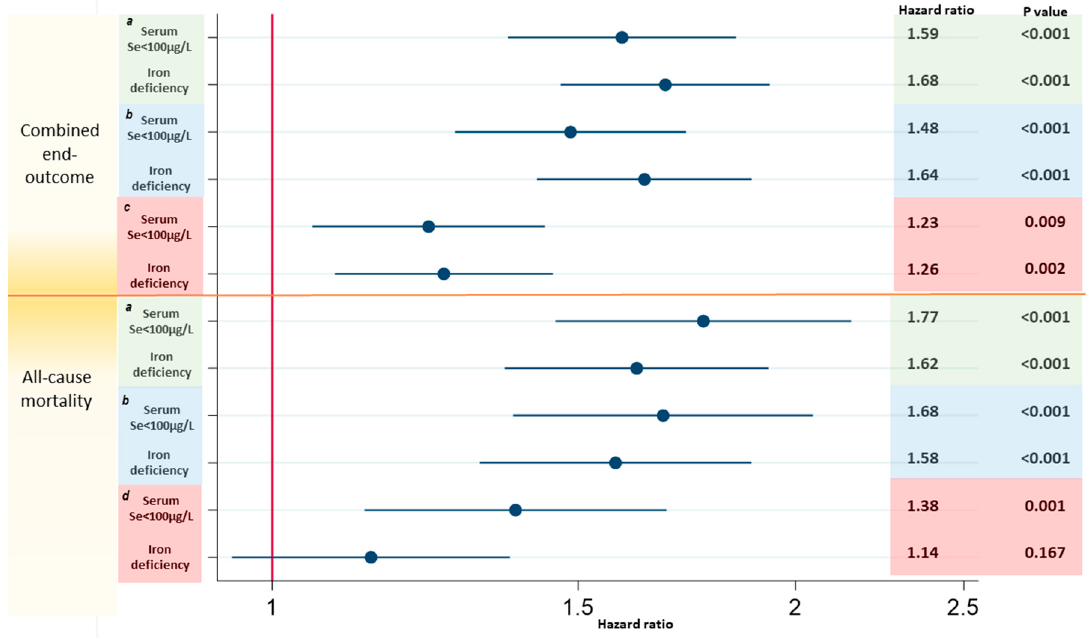
Figure 3. Comparing associations with prognosis for low serum Se concentrations and ID. Cox regression models for the prediction of the combined outcome and all-cause mortality. (a): serum selenium <100 µg/L or iron deficiency as univariate predictors in different models. (b): serum selenium <100 µg/L and iron deficiency together in one model. (c): serum selenium <100 µg/L and iron deficiency together in one model and corrected for the BIOSTAT-CHF risk-model, consisting of age, Heart Failure hospitalization in the year before inclusion, the presence of edema, higher NTproBNP, lower systolic blood pressure, hemoglobin, high-density lipoprotein (HDL) levels, serum sodium concentration, and failure to prescribe a beta-blocker. (d): serum selenium <100 µg/L and iron deficiency together in one model and corrected for the BIOSTAT-CHF mortality risk-model, consisting of age, higher blood urea nitrogen (BUN), NT-proBNP, hemoglobin, and failure to prescribe a beta-blocker.